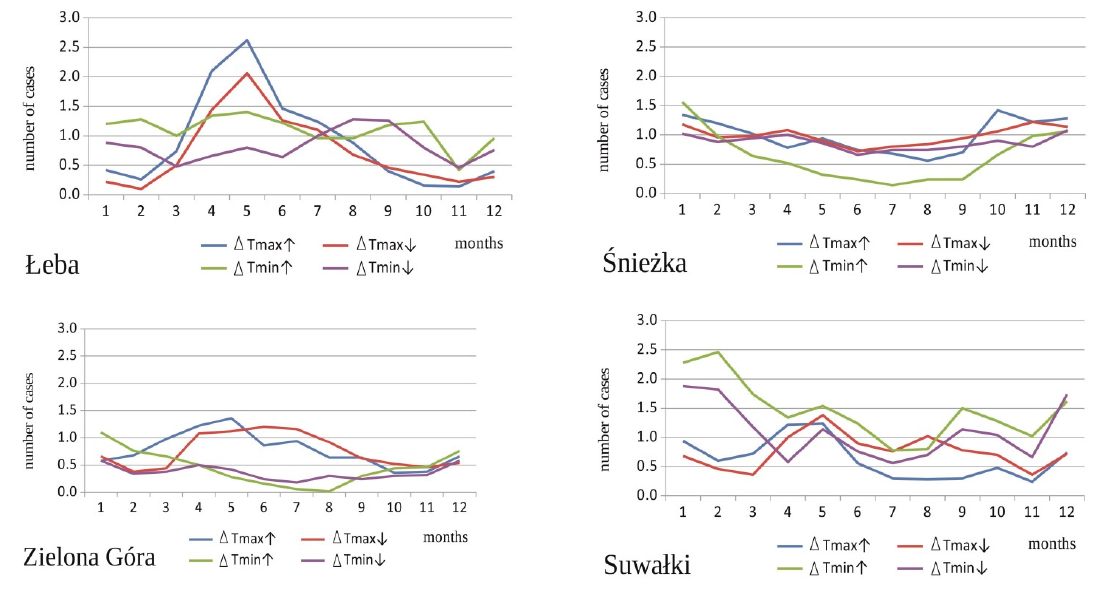
Figure 8. Mean monthly number of cases of large day-to-day increase ( ↑ ) and decrease ( ↓ ) in Tmax and Tmin in Poland in the years 1966–2015.